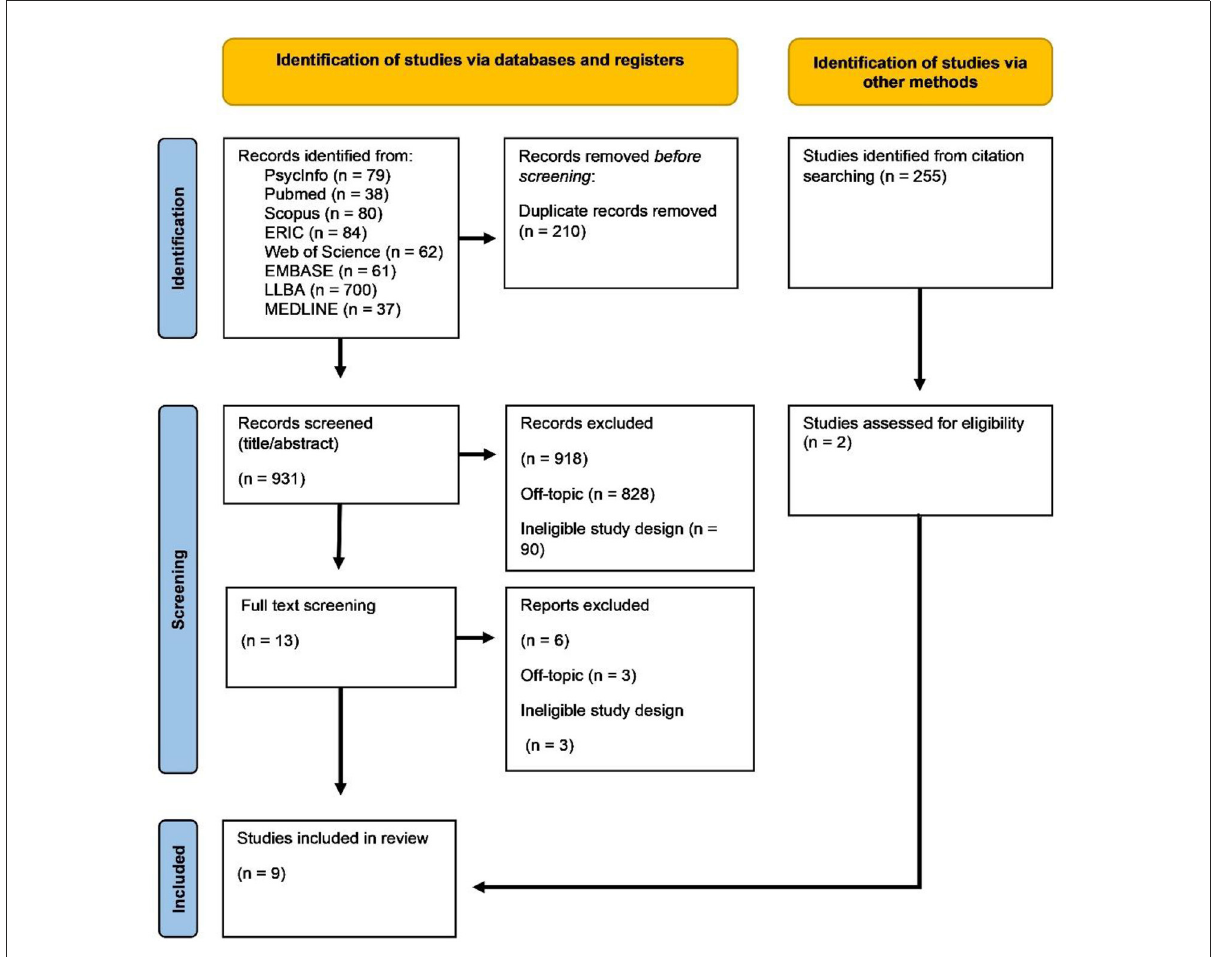
FIGURE1 Combined results from first, second, and third